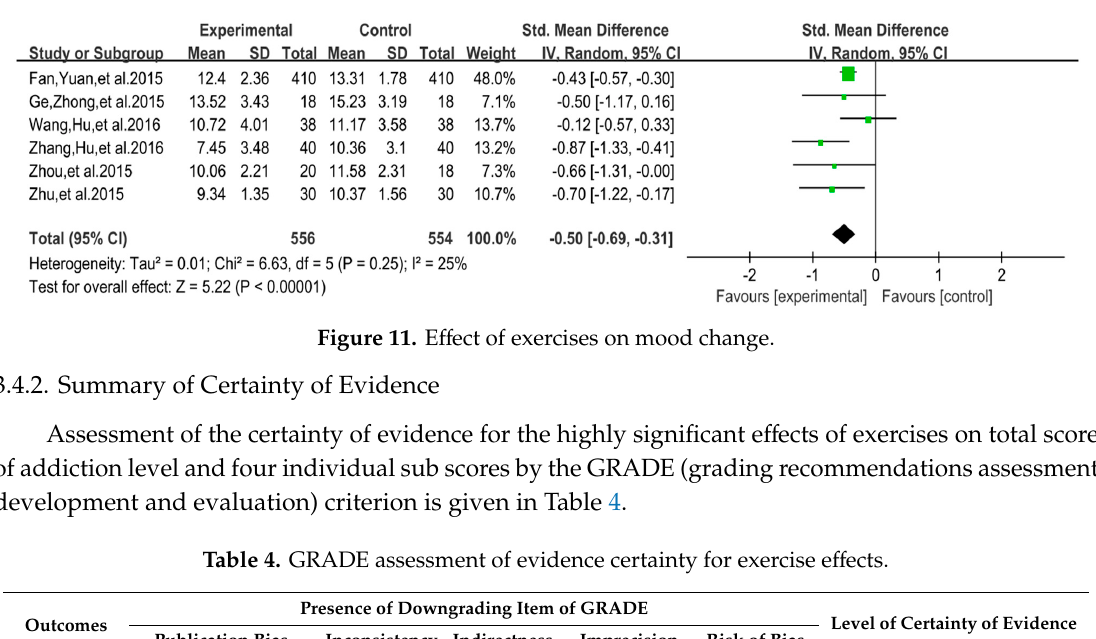
Figure 10. Funnel plot for publication bias of mood change.